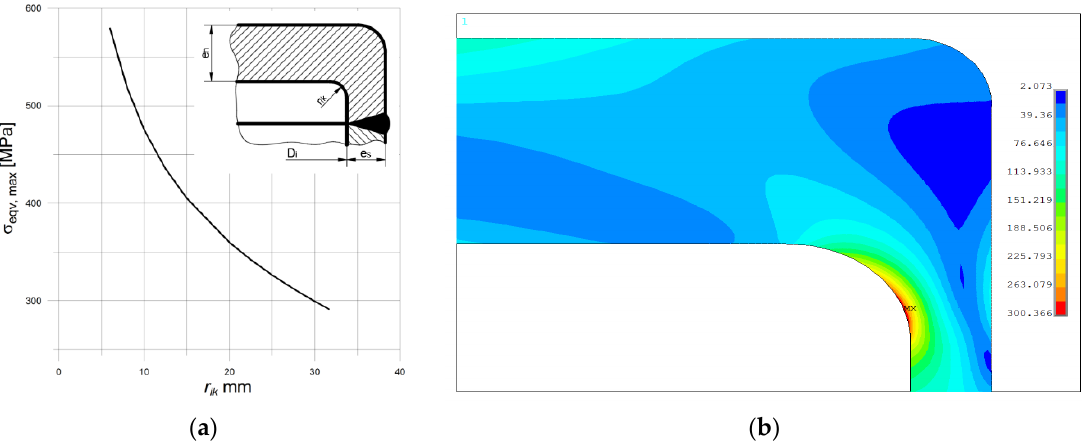
Figure 19. Bottom type “a”: ( a ) Maximum equivalent stress vs. inner radius; ( b ) distribution of equivalent stress in the stress concentration area, r ik = 30 mm.